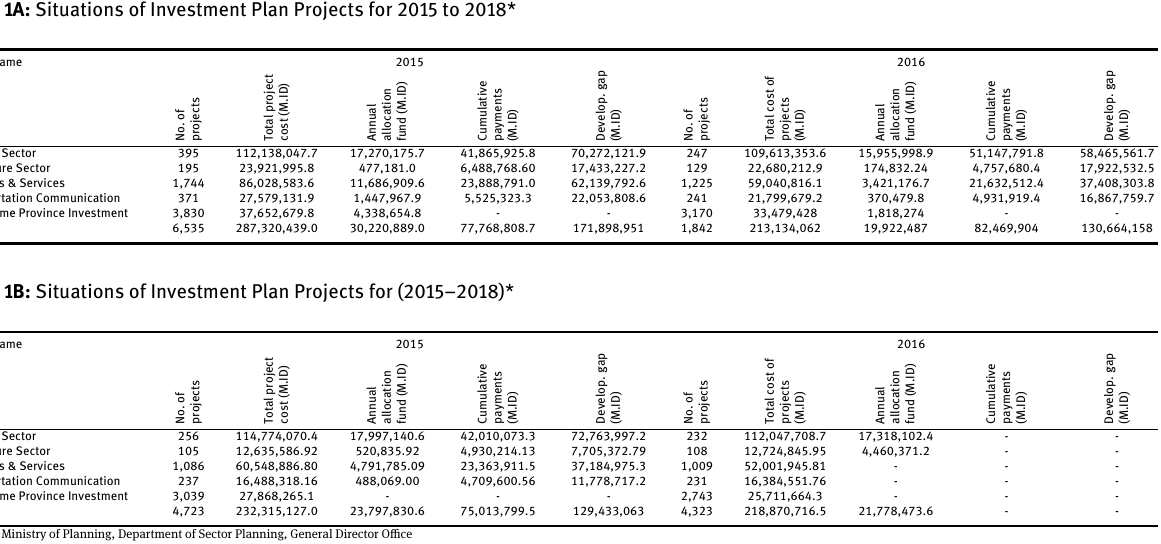
*Source:MinistryofPlanning,DepartmentofSectorPlanning,GeneralDirectorOffice Table 2: Expected Iraqi Oil Production and Revenues Year Oil production million (bbl./d)